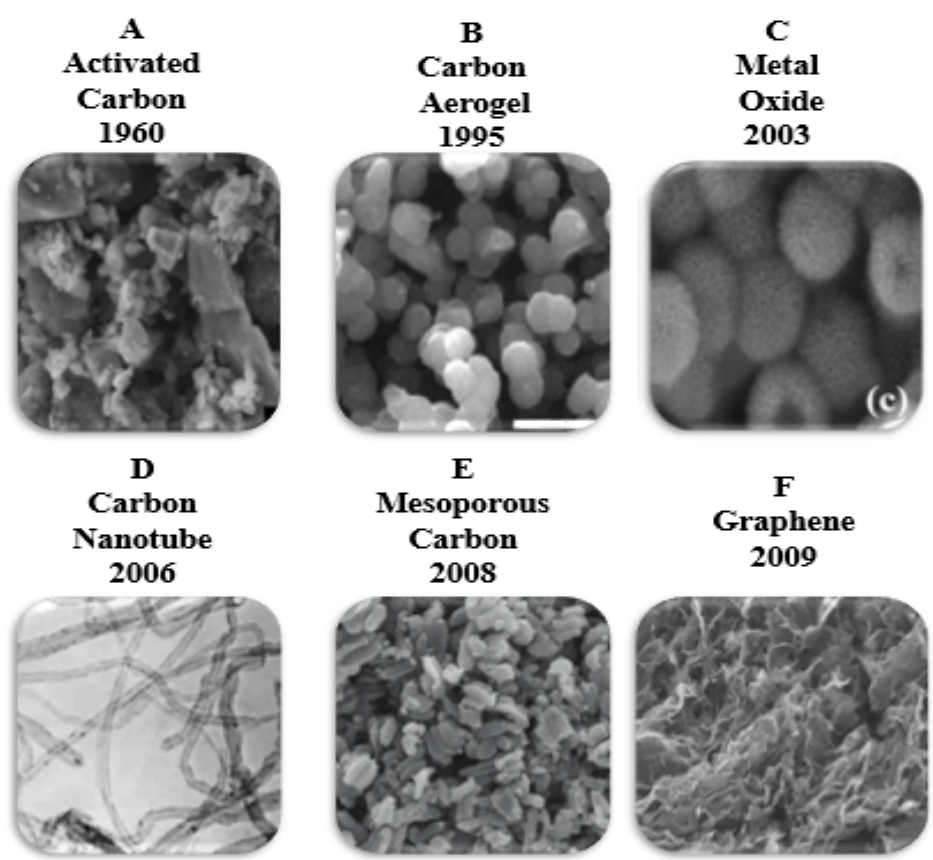
Figure 21. Development process and materials used to make the electrode in the capacitive process: ( A ) Activated carbon, Reprinted/adapted with permission from Ref. [117]. 2013, Luciano et al. ( B ) Carbon Aerogel, Reprinted/adapted with permission from Ref. [176]. 2006, Li et al. ( C ) Metal oxides, Reprinted/adapted with permission from Ref. [177]. 2013, Bian et al. ( D ) Carbon Nanotubes, Reprinted/adapted with permission from [178]. 2006, Zhang et al. ( E ) Mesopores carbon, Reprinted/adapted with permission from Ref. [179]. 2019, Liu et al. ( F ) Graphene, Reprinted/adapted with permission from Ref. [173]. 2020, Han et al.